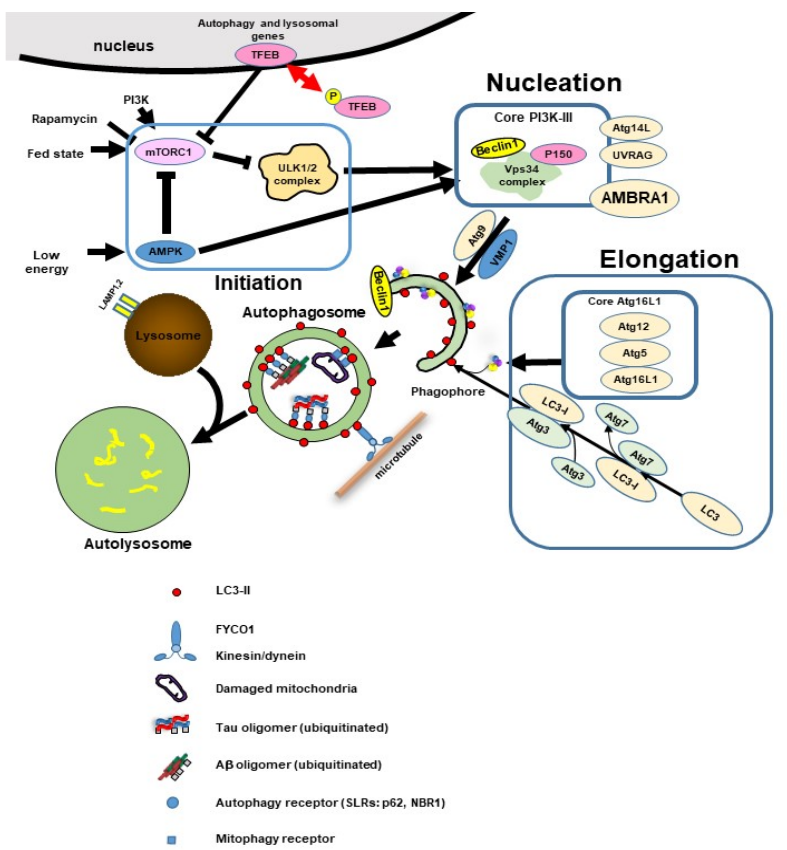
Figure 4. The sequence of autophagy in mammals. a. Initiation. In response to nutrient deprivation, AMPK phosphorylates mTORC1, releasing its inhibition on ULK, and activates the initiation complex. Downregulation of mTORC1 leads to the translocation of TFEB to the nucleus, where TFEB becomes upregulated, and various autophagy- and lysosome-related gene translation is done. ULK phosphorylates AMBRA-1, which promotes the interaction of Beclin-1 with p150 and PI3K-III (Vps34) in the PI3K-III complexes. UVRAG and Atg14L bind differently to form separate PI3K-III-complex populations in cells. AMBRA-1 also interacts with PI3K-III- complexes. B. Nucleation. ULK- and PI3K-III-complexes are translocated to early phagophore sites later with the help of Atg9 and VMP1, and local production of PI3P causes the recruitment of additional effectors and the first segregating membrane is formed. C. Elongation. Immediately after the activation of autophagy, Atg7 is upregulated, promoting Atg5-Atg12 dimer formation, which connects to Atg16L1 to form the Atg16L1 elongation complex. Atg7 also oversees the cleavage and lipidation of LC3 to LC3-I and then to LC3-II, which binds to the inside and outside of the formed phagosomal membrane. Mitochondria can be directly bound by mitochondrial receptors without poly-ubiquitination. In aggrephagy, poly-ubiquitinated protein aggregates (A β oligomer and tau oligomer) are engulfed by the phagophore via SLRs (sequestosome 1/p62-like receptors), which include P62 or NBR1. D. Maturation. Once the loaded phagophore is closed and the outer fraction of LC3-II is removed, the completed autophagosome fuses with the lysosome via a bonding process involving syntaxin members, and LAMP-1 and -2 creating an autolysosome. Autophagosomes are produced in the cytoplasm at random sites. The autophagosomes are delivered to lysosomes at the microtubule-organizing center. Transport of autophagosomes toward the plus end of microtubules involves the interaction of the LIR motif of FYCO1 with LC3-II on the outer membrane of the autophagosome. Abbreviations: PI3K-III: class III phosphatidylinositol 3-kinase; LC3-II: microtubule-associated protein light chain 3-II; LAMP-1, LAMP-2:lysosome- associated membrane protein 1, 2; SLRs: Sequestosome 1/p62-like receptors; FYCO1: FYVE and coiled-coil domain containing 1; p62: p62/sequestosome-1; NBR1: neighbor of BRCA1 gene 1; TFEB: transcription factor